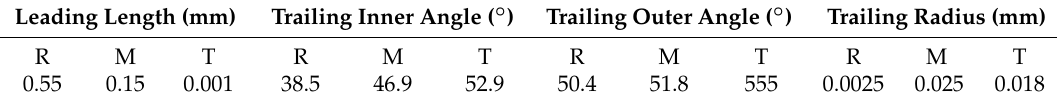
Table 13. Final parameters of the rotor’s leading length and trailing edge blade profiles.